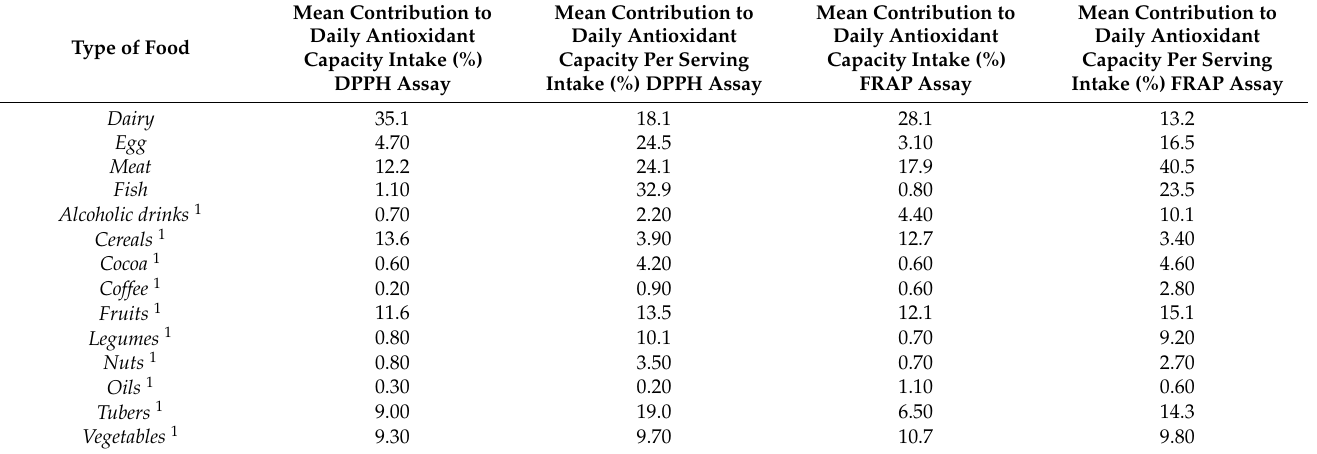
Table 3. Antioxidant capacity distributed as a % of each food group in relation to the total diet.